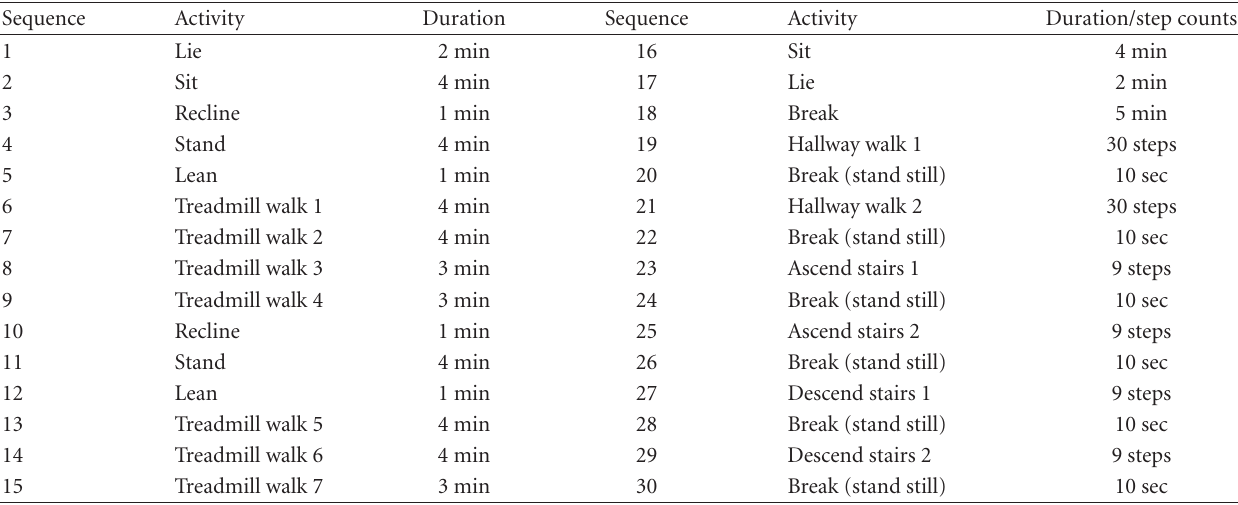
Figure 1: Representative diagram showing the IDEEA monitor secured to a person’s waist with five sensors attached to the chest, both thighs, and the soles of both feet. The IDEEA monitor is about the size of a pager and collects data in the free-living state. Each sensor is the size of a thumb nail. Table 1: Activity protocol for IDEEA monitor accuracy